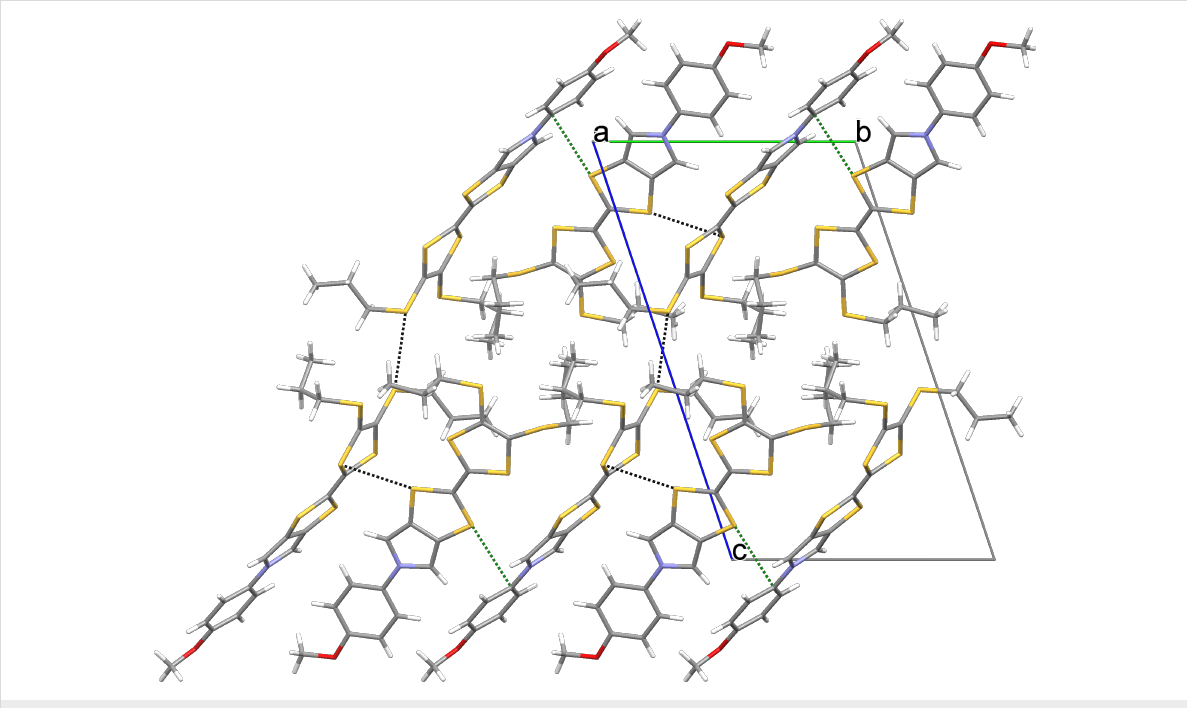
Figure 5: Crystal packing of 4a viewed along the a axis and showing one layer of molecules. Short S···S contacts are shown as black and S···C contacts as green dashed lines. Only the major orientation of the disordered propyl chain is shown.